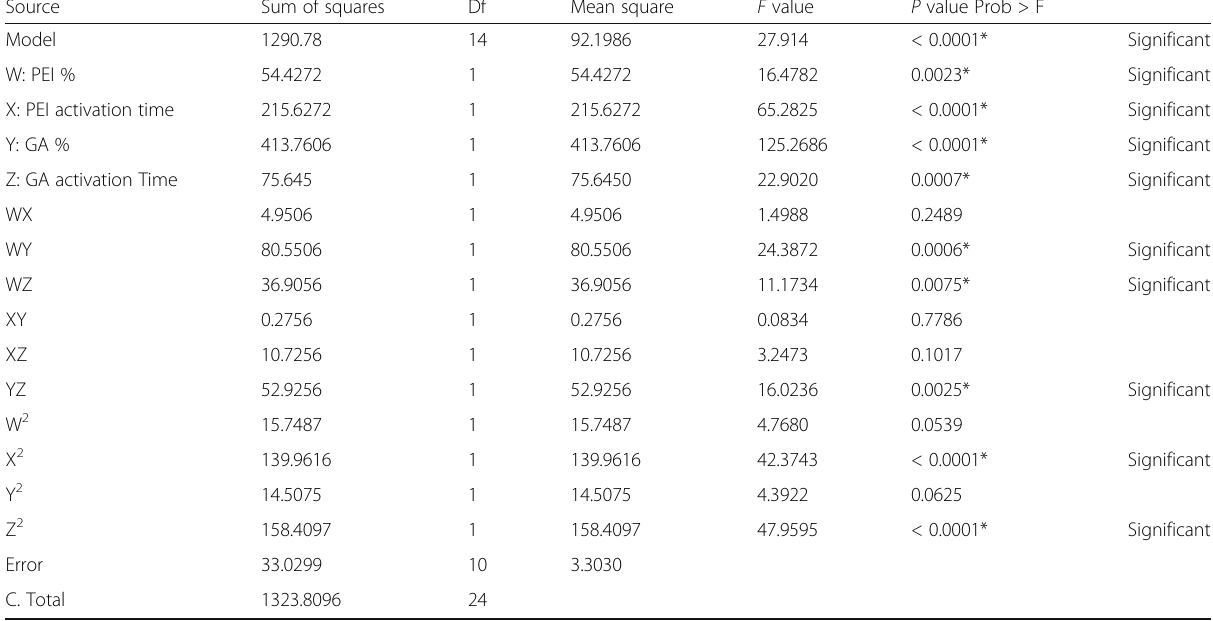
Table 2 Analysis of variance (ANOVA) for